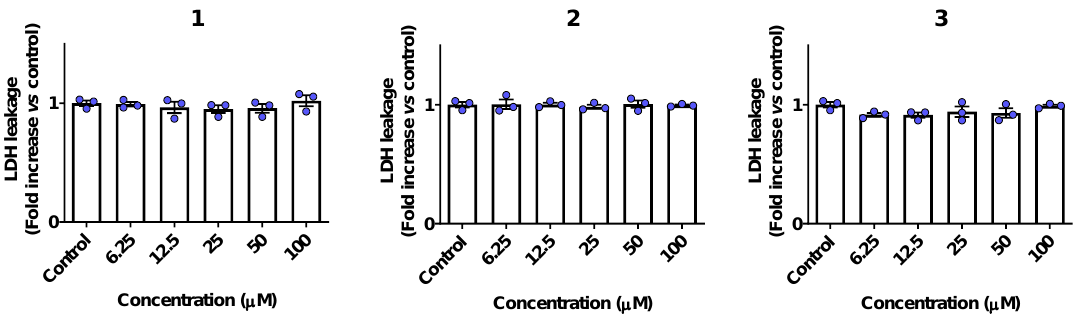
Figure 9. LDH activity found in the culture media of HaCaT cells treated with 1 – 3 for 24 h at the concentrations presented. Triton X-100 was used as a positive control to lyse cells.